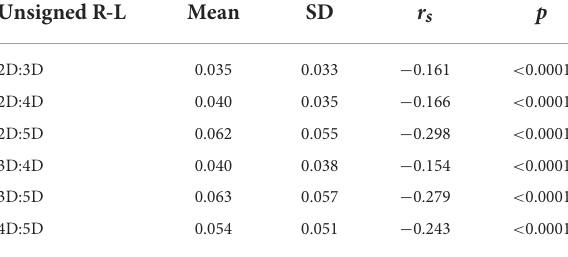
TABLE 2 Means, SDs for six unsigned asymmetries together with Spearman correlations for relationships with age.